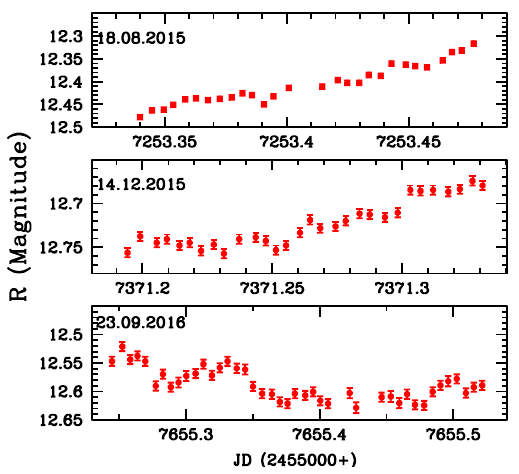
Figure 3. Typical examples of LCs of BL Lacertae where ∆ m > 0.10 in a few hours.